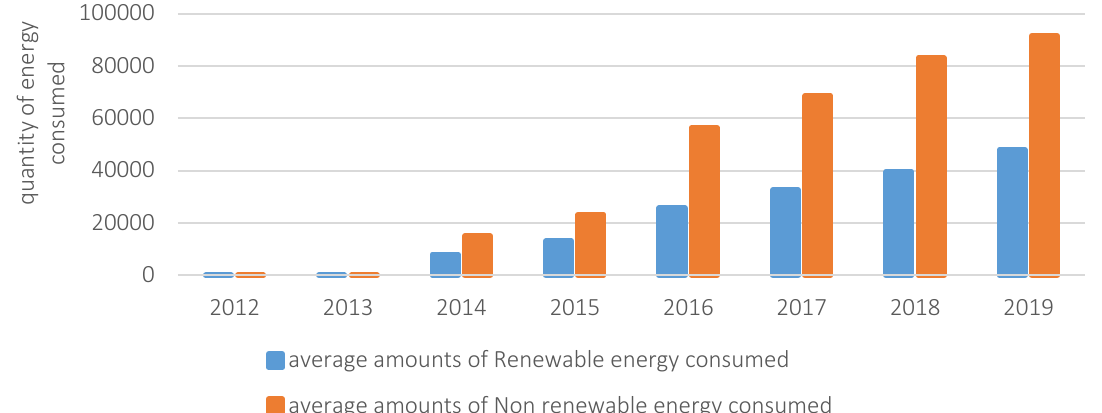
Figure 2. Evolution of manufacturing firms’ average energy consumption in Cameroon (2012 and